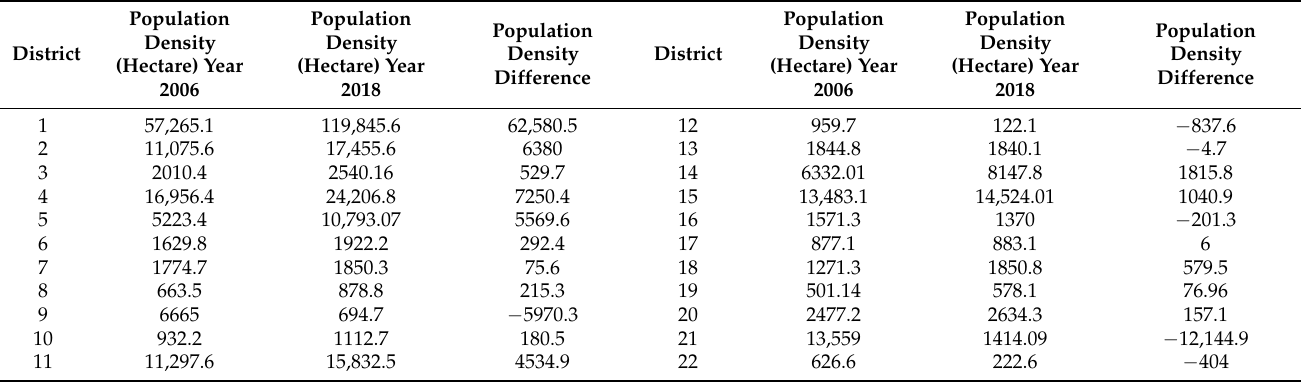
Table 6. Demographic indices/density of 22 municipality districts of Tehran